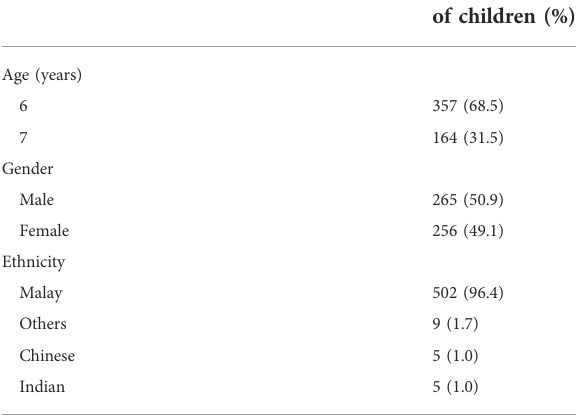
TABLE 3 Socio-demographic characteristic ( n =